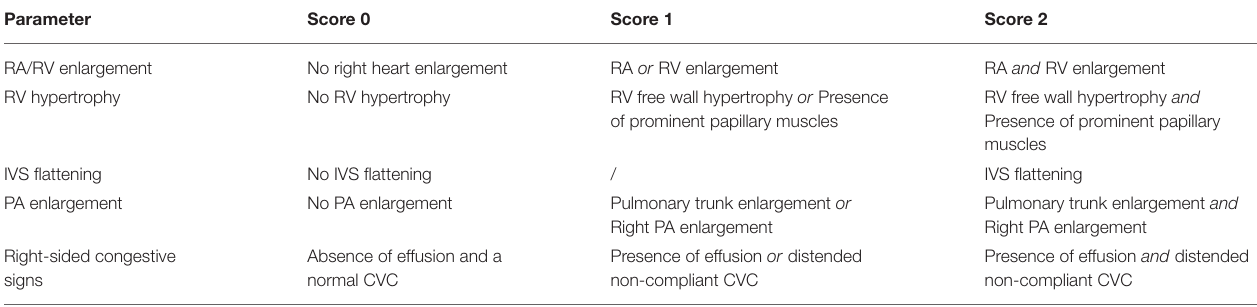
TABLE 1 | Pulmonary hypertension scoring system (PHS) for each evaluated right-sided echocardiographic